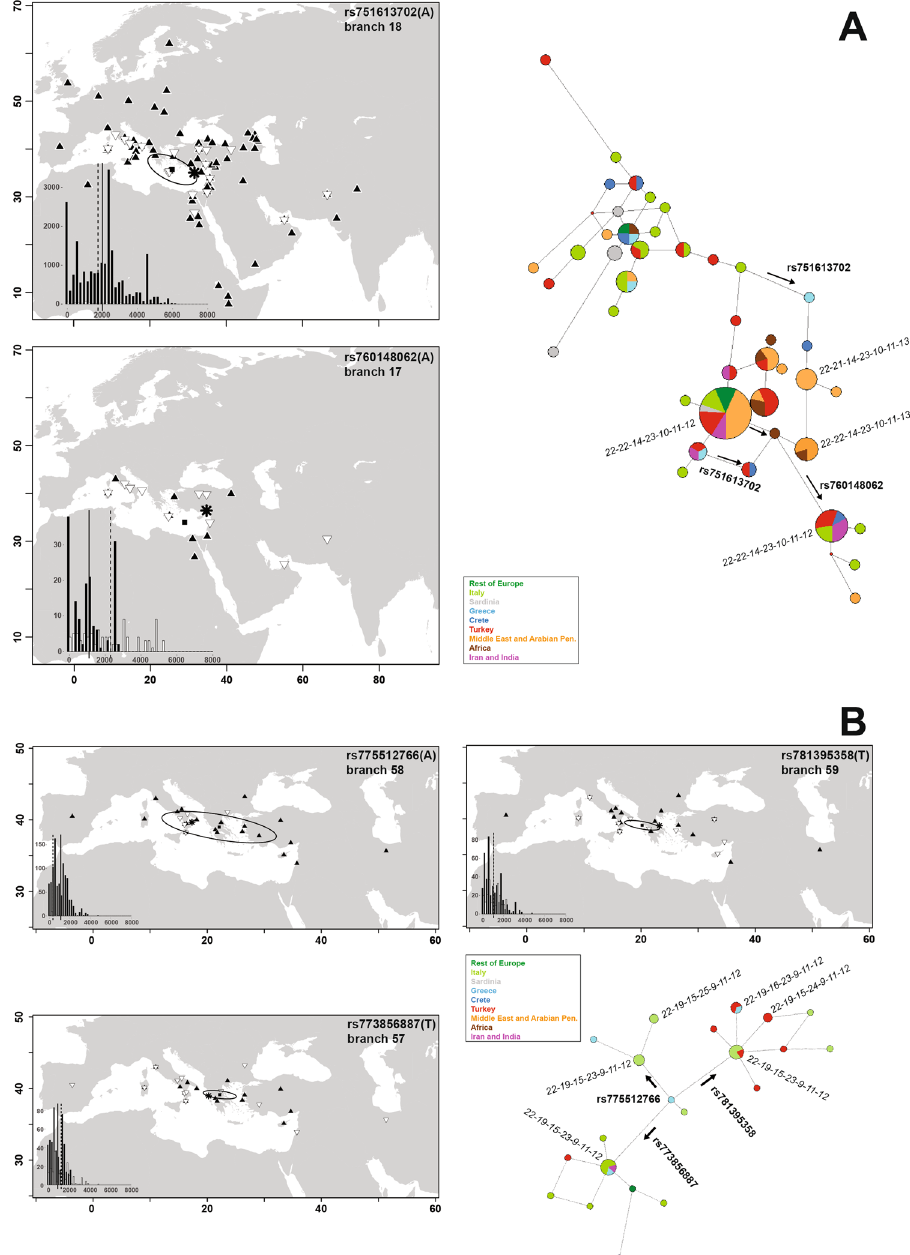
Figure 2. Maps of sampling locations for the carriers of the derived allele (white triangle point down) at the indicated SNP vs carriers of the ancestral allele (black triangle point-up), conditioned on identical genotype at the same most terminal marker. Coastlines were drawn with the R packages “map” and “mapproj” v. 3.1.3 (https://cran.r-project.org/web/packages/mapproj/index.html), and symbols added with default functions. ( A ) J1; ( B ) J2-L397. The star indicates the centroid of derived alleles. The solid square indicates the centroid of ancestral alleles, with its 95% C.I. (ellipse). In the insets: distributions of the pairwise sampling distances (in Km) for the carriers of the ancestral (black) and derived (white) allele, with solid and dashed lines indicating the respective averages. At right: median joining network of 7-STR haplotypes and SNPs in the same groups, with sectors coloured according to sampling location. Haplotype structure is detailed for some nodes, in the order YCA2a-YCA2b-DYS19-DYS390-DYS391-DYS392-DYS393 (in